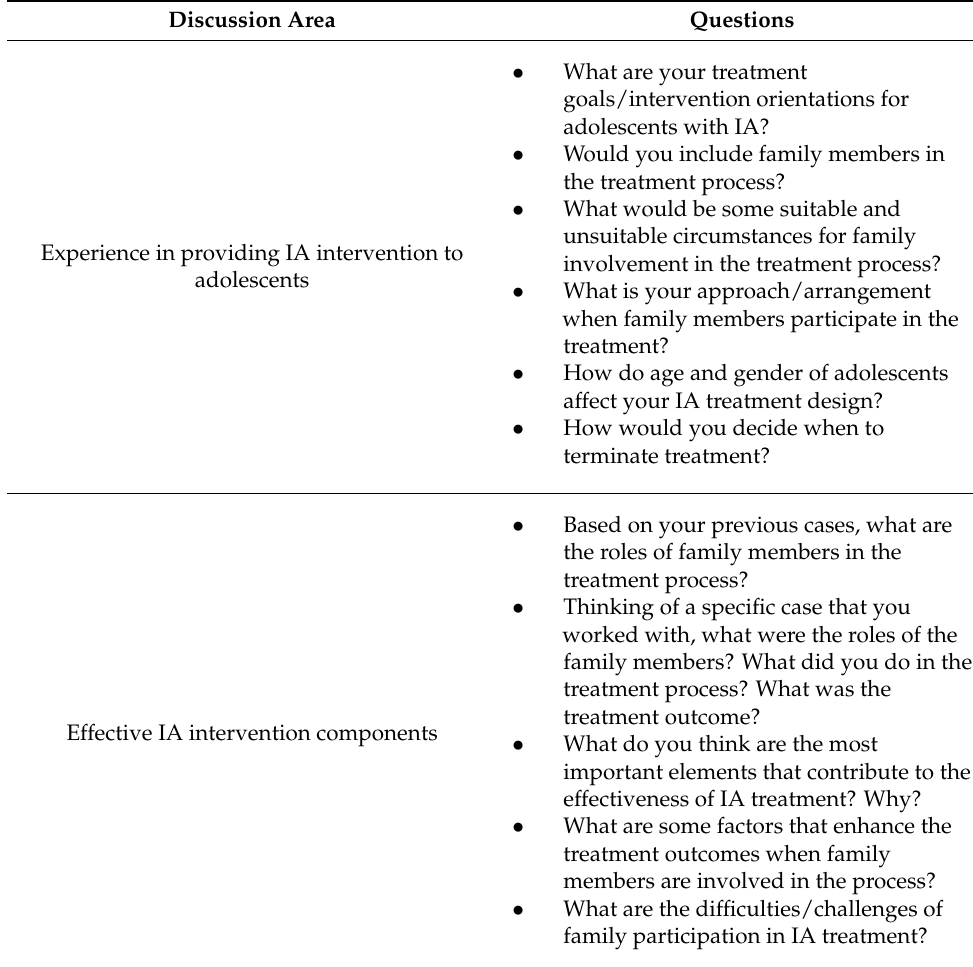
Table 1. Interview